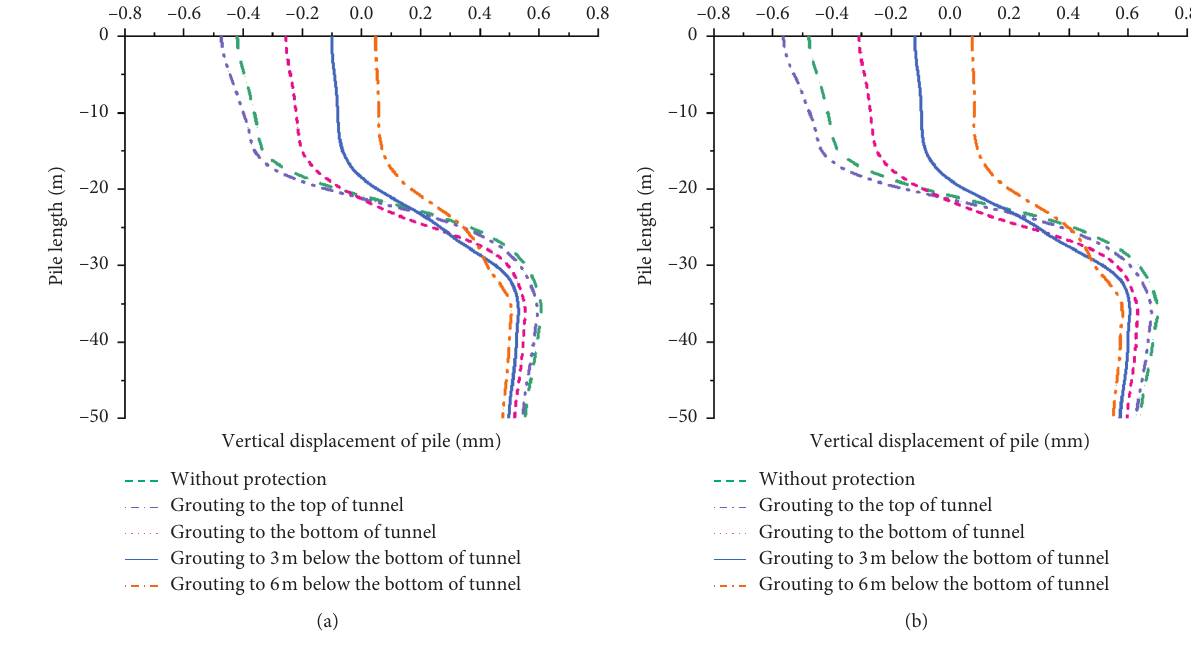
Figure 8: Vertical displacement of the pile: (a) 2 rings after passing the pile; (b) 4 rings after passing the pile.